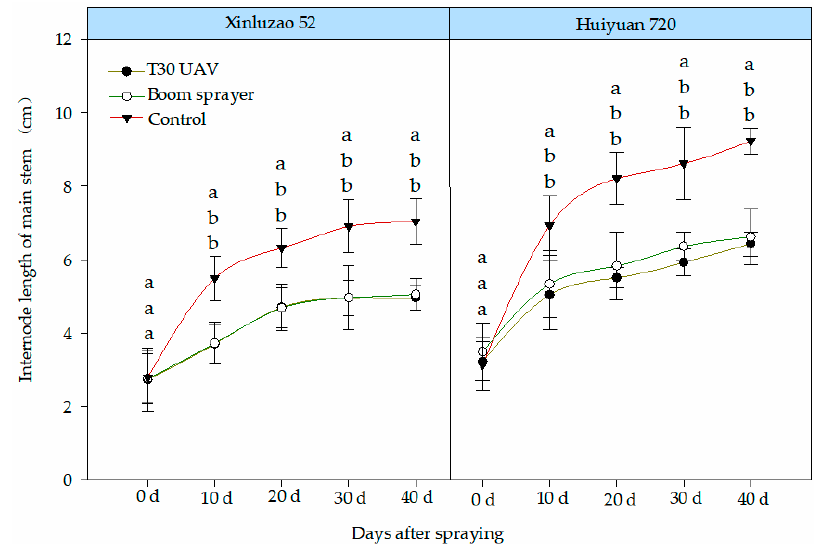
Figure 9. Effects of spraying a chemical topping agent with two sprayers on the internode length of the main stem. Different lowercase letters indicate significant differences between treatments at the 5% probability level ( p < 0.05).